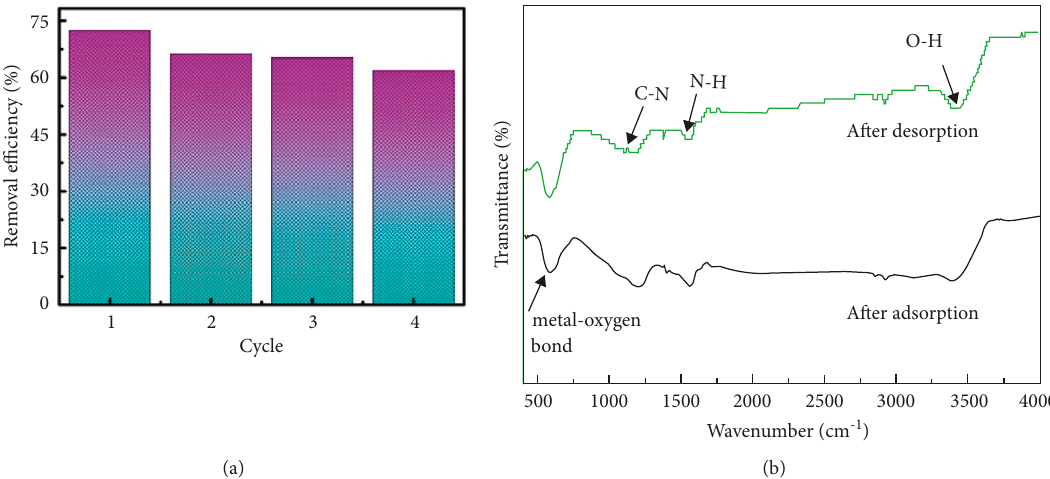
Figure 8: (a) Cyclic adsorption of Cr (VI) on TGOM ( T � 298K pH � 2, m / V � 0.1g/L, C and